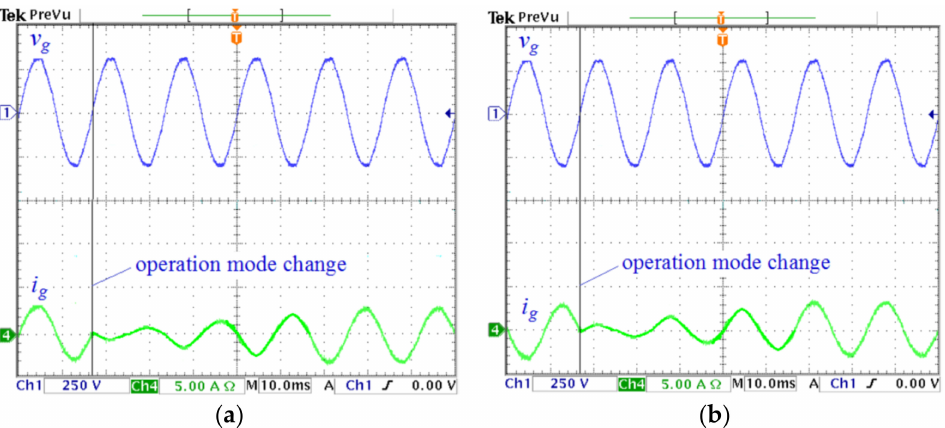
Figure 6. Experiment waveforms for the operation mode changes: ( a ) waveforms from the inverter mode to the rectifier mode; ( b ) waveforms from the rectifier mode to the inverter mode.